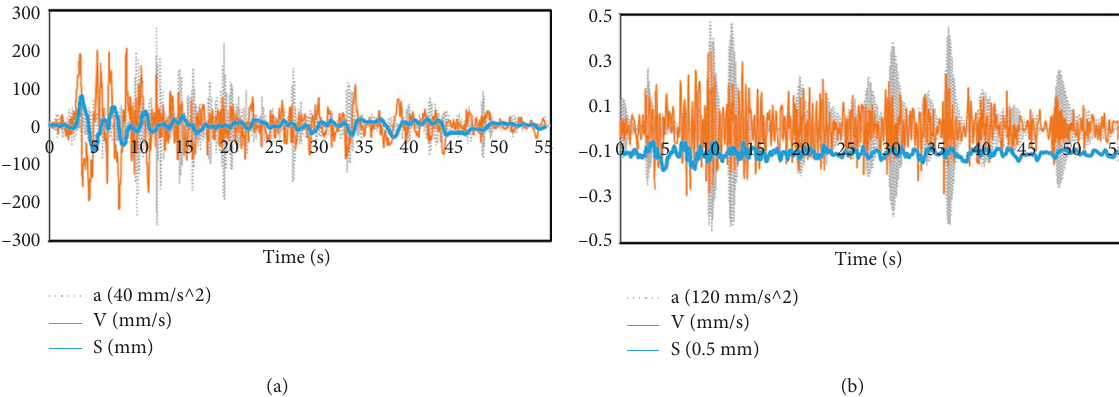
Figure 57: Time course curves of bearing deformation displacement, velocity and acceleration when TAF is input from X direction. (a) Horizontal deformation. (b) Vertical deformation.